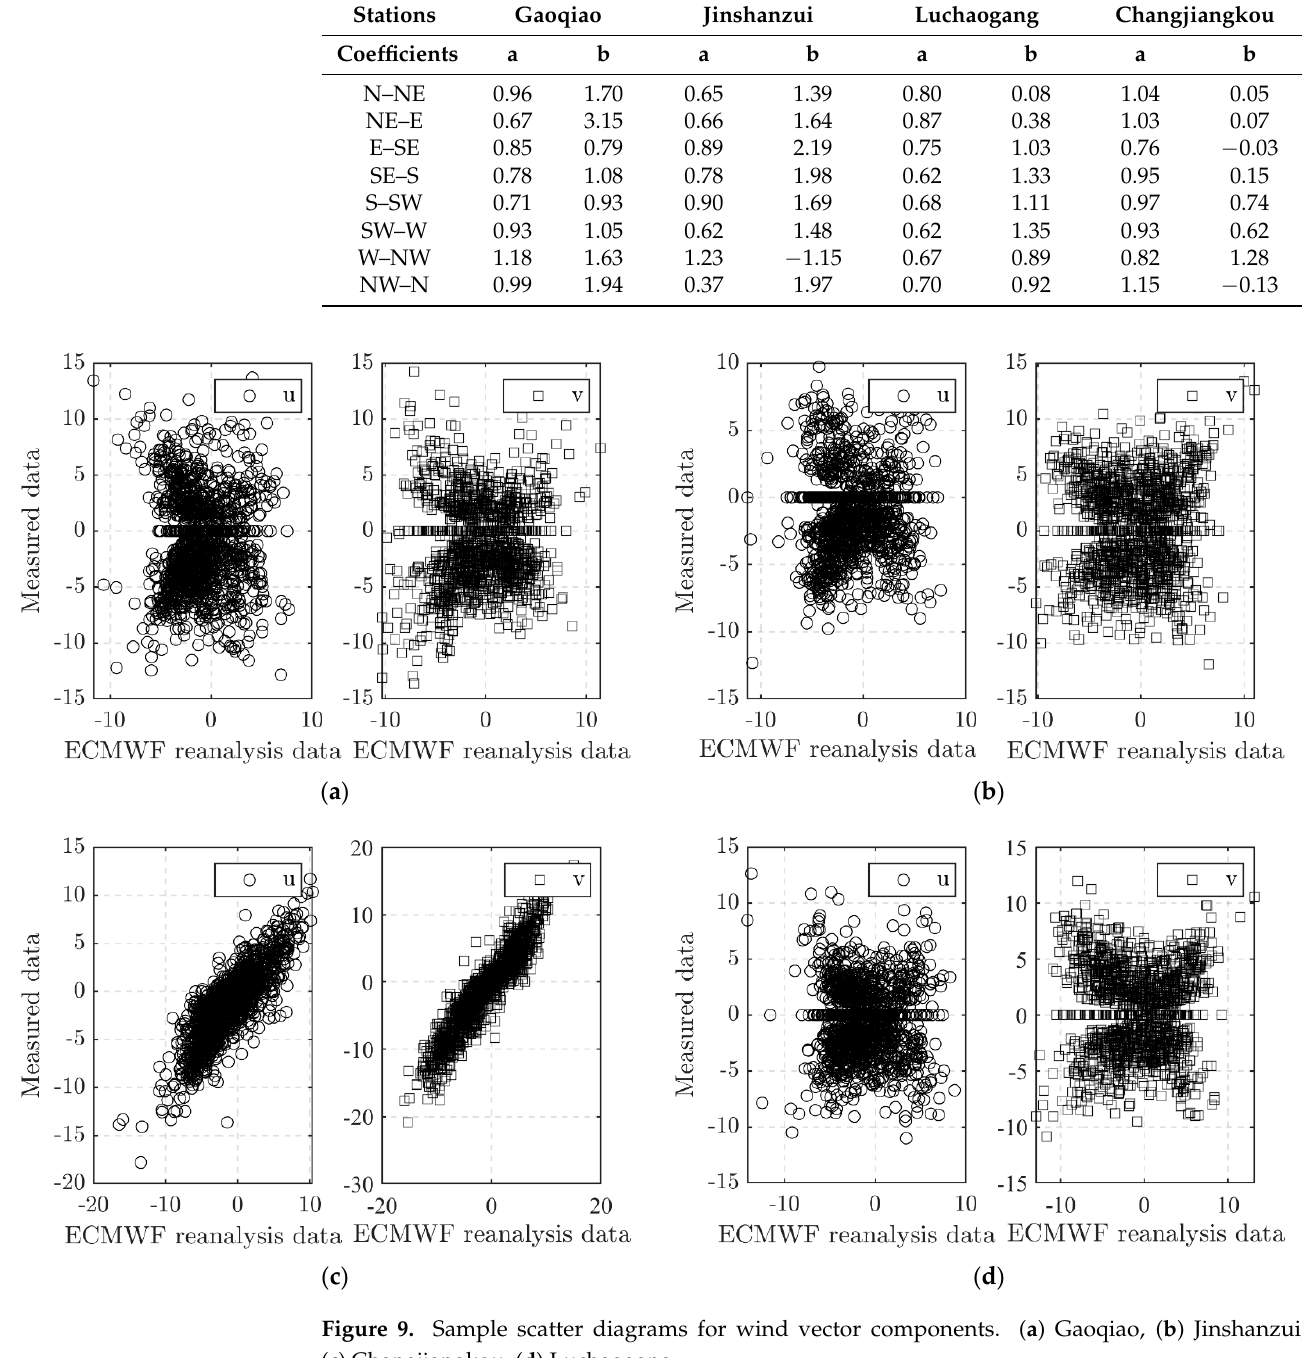
Figure 9. Sample scatter diagrams for wind vector components. ( a ) Gaoqiao, ( b ) Jinshanzui, ( c ) Changjiangkou, ( d ) Luchaogang. Table 2. Coefficients of corrections equations of wind speed at stations.